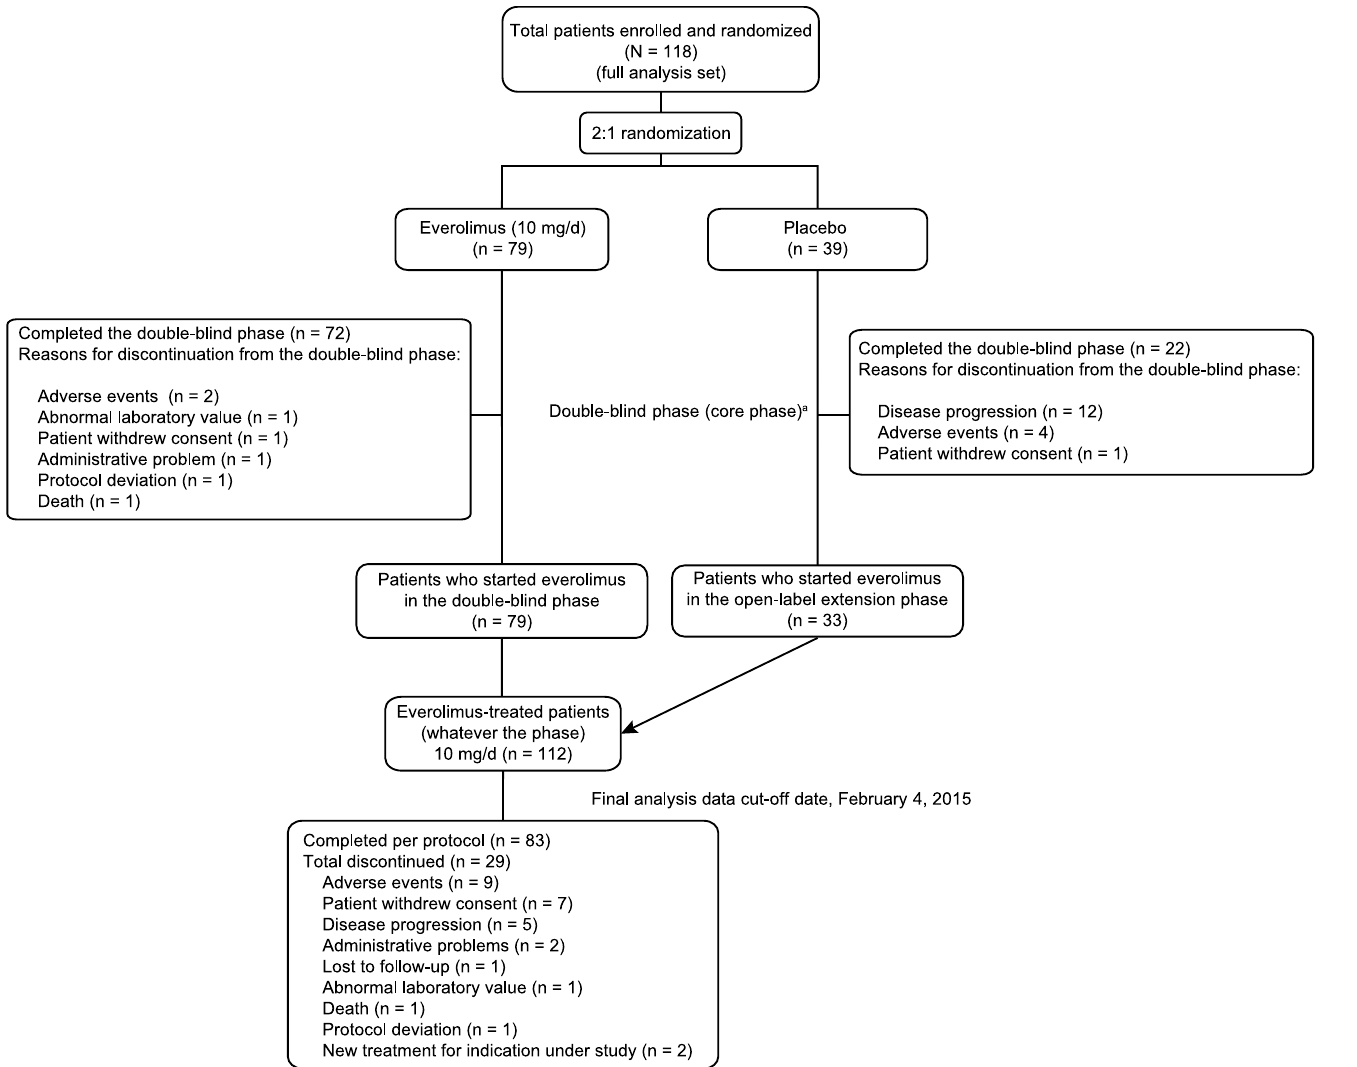
Fig 1. CONSORT flow diagram of patient disposition in the double-blind followed by open-label periods. a Patients with angiomyolipoma progression were unblinded at the end of the double-blind phase, and patients who were on placebowere allowedto cross over to